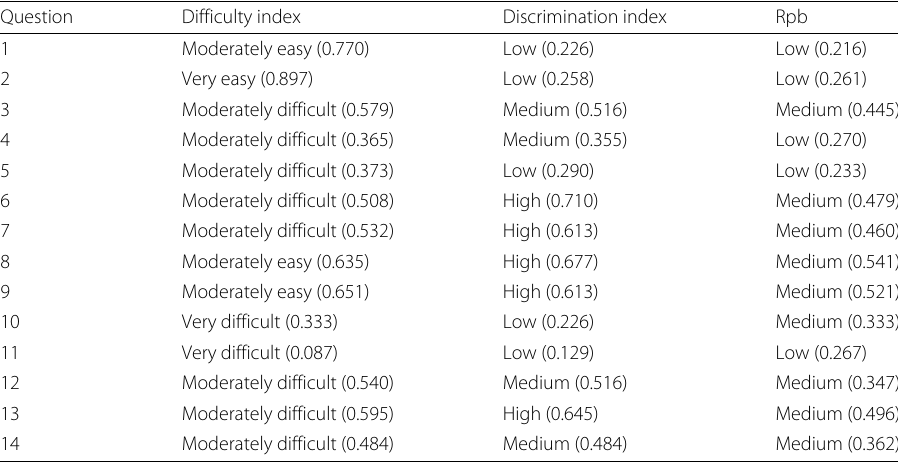
Table 13 Questions’ analysis in test-one (number of students’ attempts = 126)